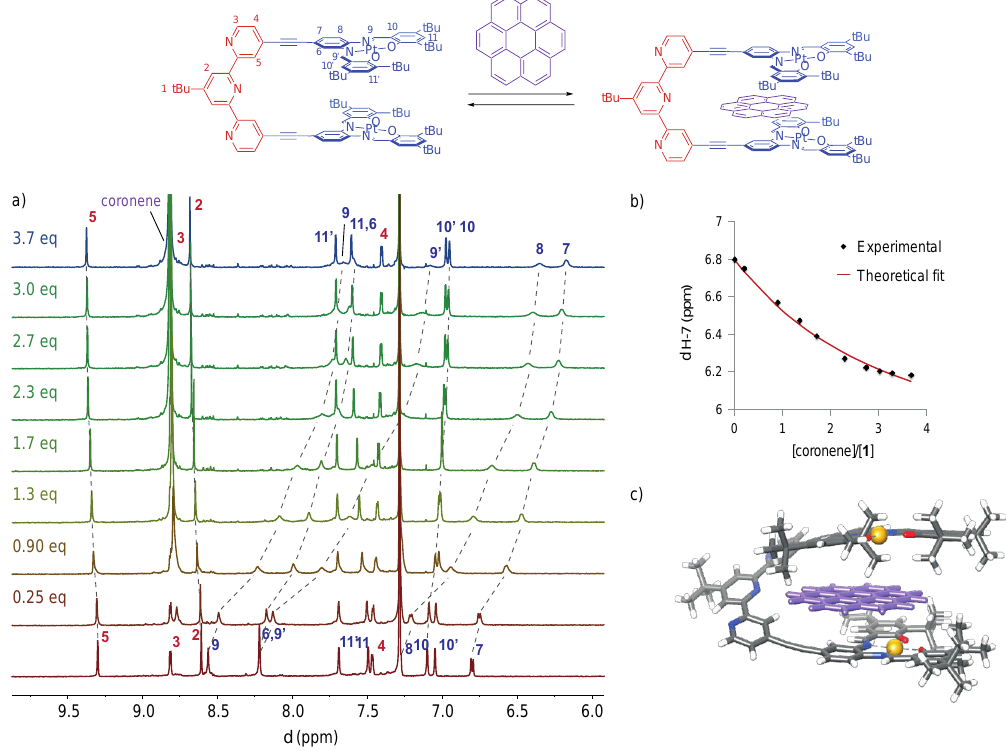
Figure 7. a ) 1 H-NMR (600 MHz) titration of Tweezers 1 (2.0 mM) with coronene in CDCl 3 at 300 K; b ) Fitting with a 1:1 binding isotherm model; and c ) DFT-optimized structure of the host guest complex [coronene ⊂ 1 ] (B3LYP/6-31G**/LanL2DZ).